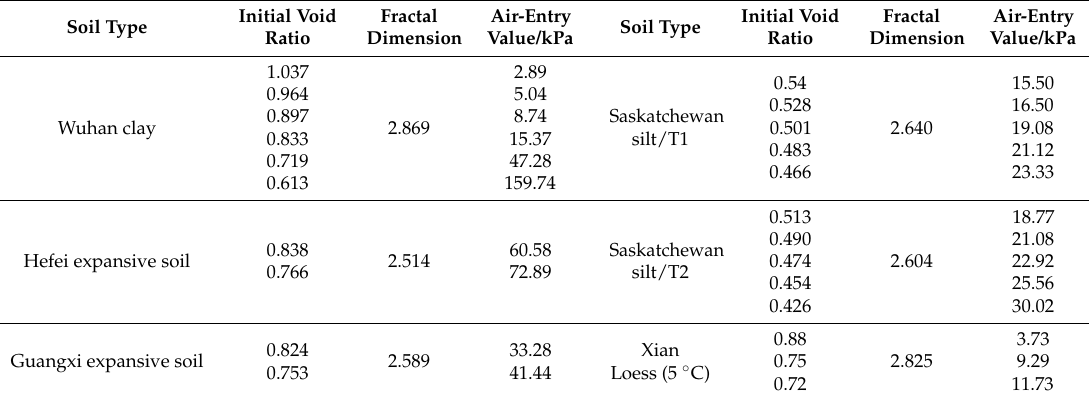
Table 2. Predictions of fractal dimensions and air-entry values at deformed state.